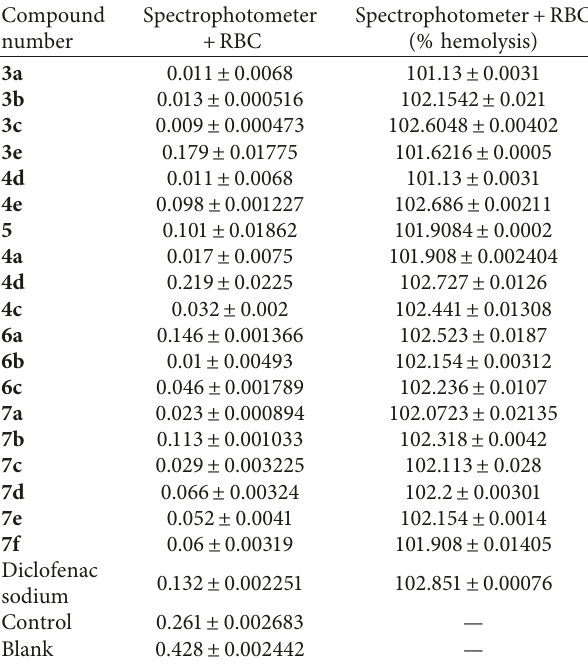
Table 3: In vitro anti-inflammatory activity of the synthesized compounds and standard drug (diclofenac